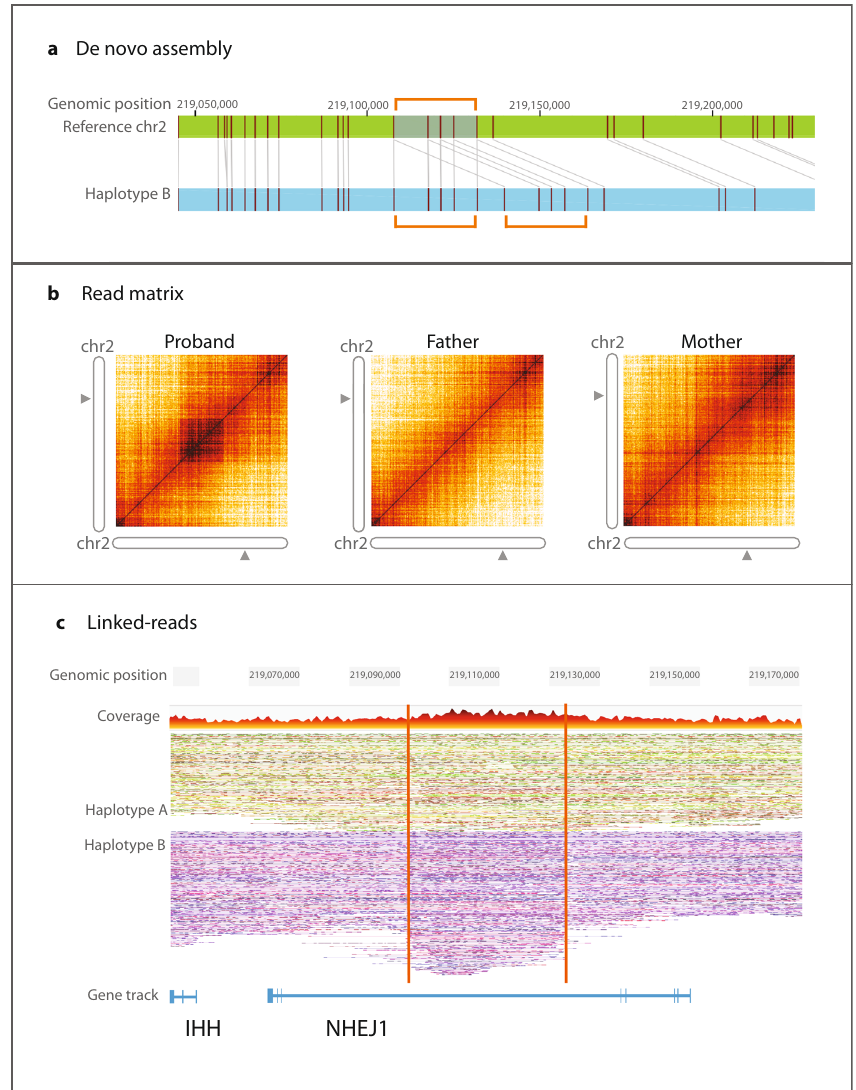
Fig. 1 Heterozygous, intronic tandem duplication (32 kb) in NHEJ1 . The region affected (chr2: 219,102,933 - 219,134,970, 2q35, genome version GRCh38) corresponds to an IHH upstream enhancer and narrows the diagnostic interval for this condition. a Depicts a de novo assembly (light blue) and its alignment to reference (green). The labeled motifs in the reference genome (vertical maroon lines) are duplicated in Haplotype B and their orientation demonstrates the duplication occurred adjacent to the original sequence, in tandem. b Shows a matrix view of linked reads. The dark orange square in the left panel (proband), illustrates a higher density of barcode overlap in the read matrix compared to parents, indicating the variant likely occurred de novo. c Contains phased haplotypes generated using linked-read data. Haplotype B, in purple, contains the intronic region with higher number of linked reads due to sequence duplication. Accompanying supplemental data show overlap with